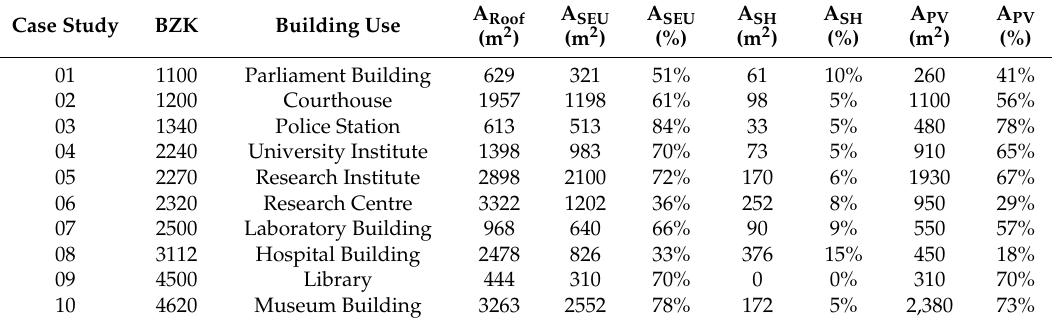
Table 3. Areas of solar energy use on the roofs of the case studies—total roof area (A Roof ), empirically measured available roof area for solar energy use (A SEU ), balanced footprint area for solar collectors (A SH ) for heat support and drinking hot water, and area for photovoltaics (A PV ); each area is in square meters and the percentage of the total roof